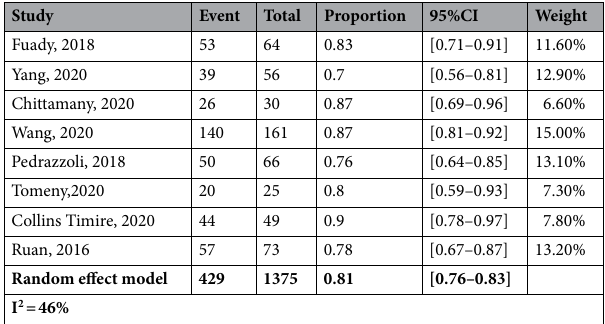
Table 3. Pooled proportion of catastrophic costs at 20% among drug resistant.